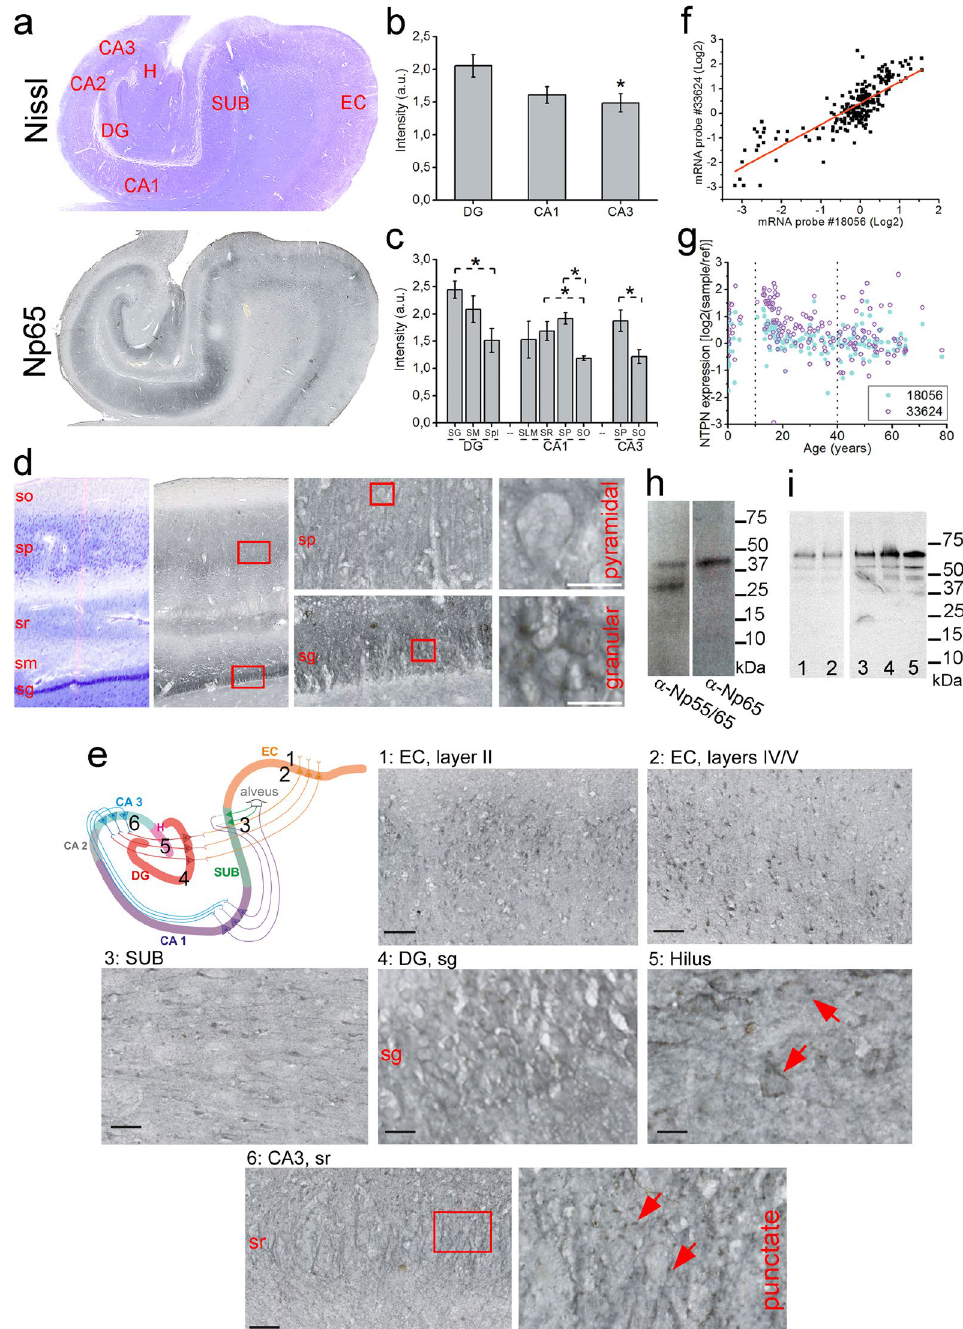
Figure 1. Localization, gene expression, and subcellular distribution of hNp. ( a , d , e ) Representative scans of Nissl staining and DAB-based detection of Np65 in human hippocampal-entorhinal cortex sections ( b , c ) Quantification of Np65 staining in hippocampal areas and sublayers ( * P < 0.05, student t-test). ( d ) Magnification of CA1-DG area. Sequential close-ups are indicated with red frames. Scale bar = 20 µ m. ( e ) Color-code drawing of the main glutamatergic pathways in the hippocampal-entorhinal cortex circuit. Numbers from 1 to 6 indicate the corresponding position of each Np65 scan. Scale bars in 1–3 and 6 = 100 µ m, 4 and 5 = 20 µ m. ( f ) mRNA expression correlation for Np65 (probe 33624, BrainCloud database) 55 vs. Np55/65 (probe 18056) (red line: Pearson’s coefficient = 0.7988). ( g ) Np mRNA expression during embryonic, young-adult, and elderly stages (dotted lines). ( h ) Chemically deglycosylated homogenates from human cortex blotted with a pan-Np55/65 or an anti-Np65 antibody. ( i ) Np55/65 in subcellular fractions from human brain cortex. 1. total homogenate, 2. total membrane, 3. synaptic membrane, 4. synaptic junction, 5. post-synaptic density (PSD). A picture of the original blot is shown in Supplementary Fig. S1d. DG, dentate gyrus; CA cornu ammonis; H, hilus; SUB, subiculum; EC, entorhinal cortex; SG, stratum granulosum; SM, stratum moleculare; Spl, stratum plexiforme; SLM, stratum lacunosum-moleculare; SR, stratum radiatum; SP, stratum pyramidale; SO, stratum